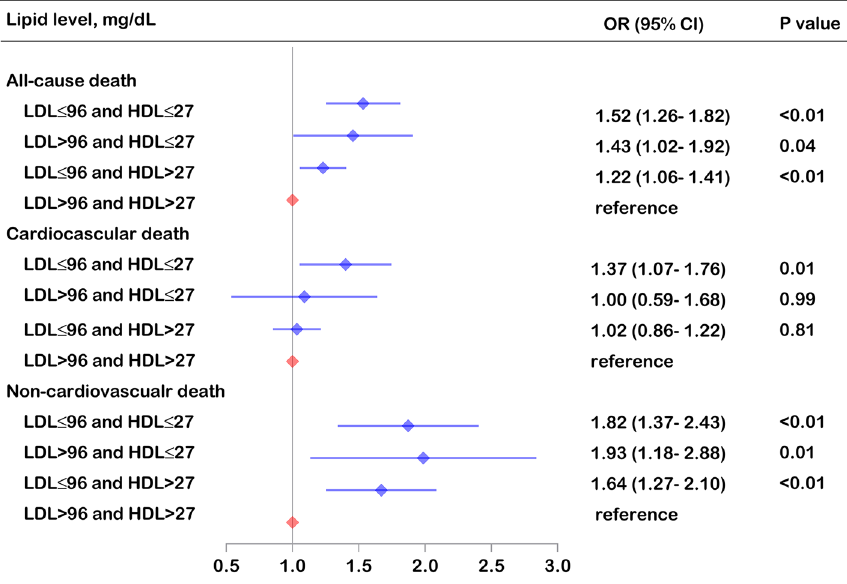
Figure 4. Multivariable adjusted all-cause and cause-specific mortality risk according to the risk inflection point of LDL-C and HDL-C. The model was adjusted by age, sex, ethnicity, BMI, heart rate, mean blood pressure, disease severity score (APACHE score, Glasgow Coma Score), lab measurement (LDL-C, HDL-C, TC, TG, white blood cell, hemoglobin, platelet and albumin), primary disease of admission (circulatory disease, respiratory disease, digestive disease, neurological disease, genitourinary disease and endocrine disease), pre-admission comorbidities (ASCVD, diabetes, hypertension, heart failure, COPD and renal dysfunction), medication (lipid-lowering therapy, antiplatelet drug and anticoagulant), mechanical ventilation and